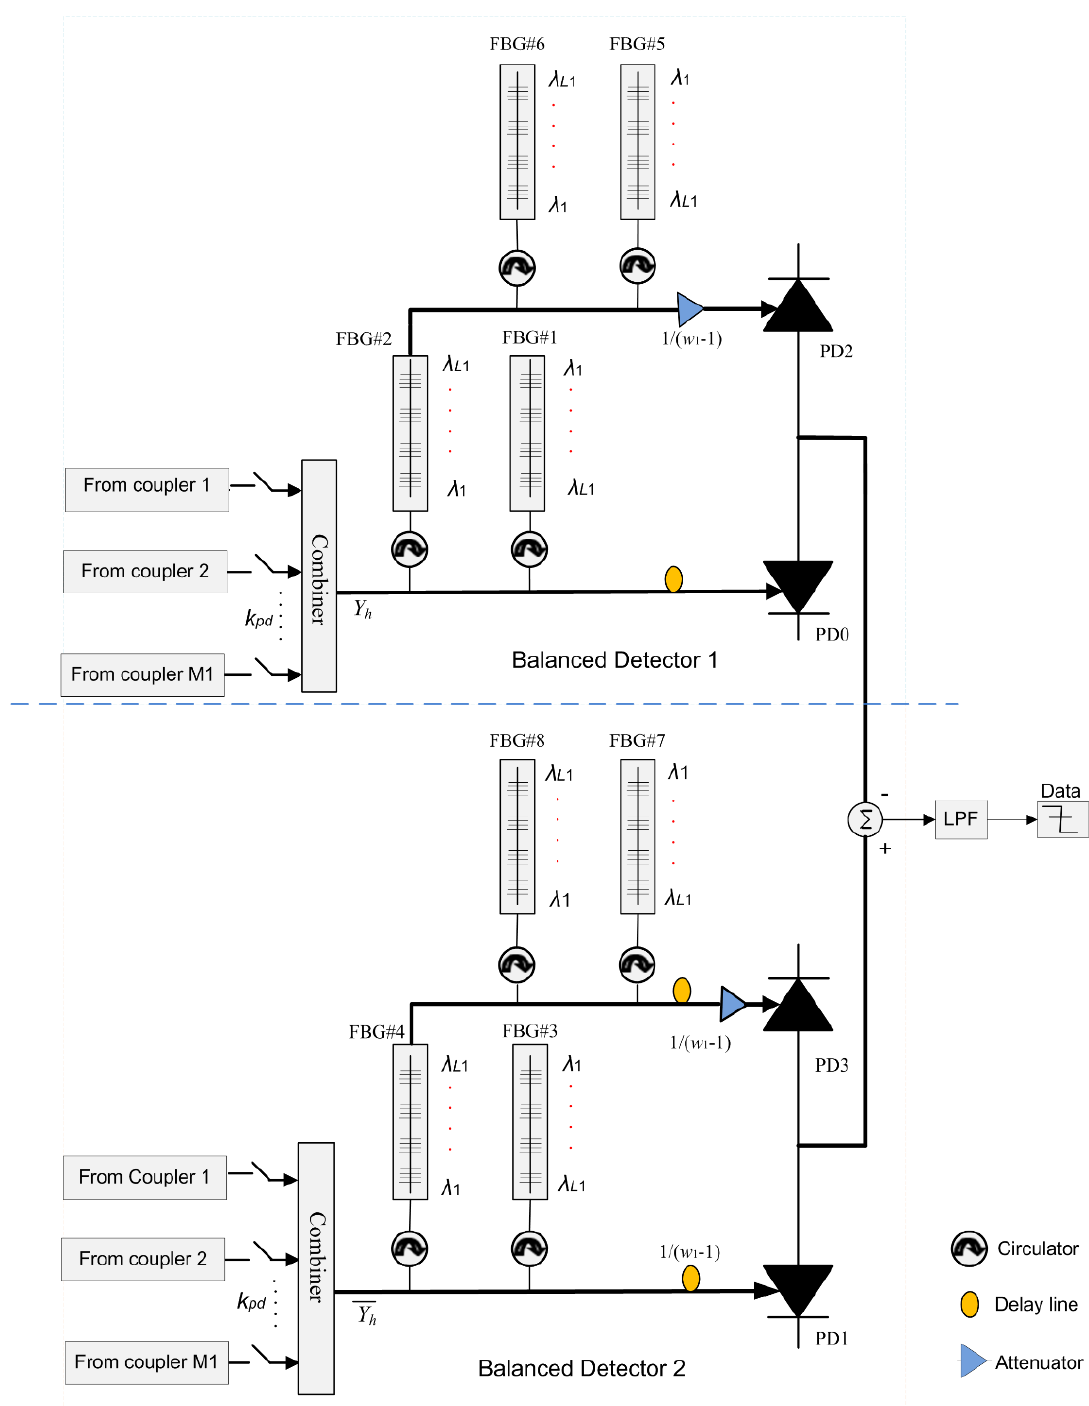
Figure 2. Receiver structure of the 2D-BIBD OCDMA system. Both balanced detectors operations are similar except for the attenuation values. In this case, the spectral components which are matched with FBG#2 are transmitted to FBG#1 and a delay line. The function of the delay line is to compensate for the delay caused by FBG#5 and FBG#6. After this, optical pulses are sent to photo diode PD0. In the same way, the spectral components matched with FBG#6 are further sent to FBG#5 and an optical attenuator (value set to [ 1/ ( w 1 − 1 )] ) which is derived from the SNR expression analysis of the proposed 2D-BIBD code. Next, optical pulses are sent to